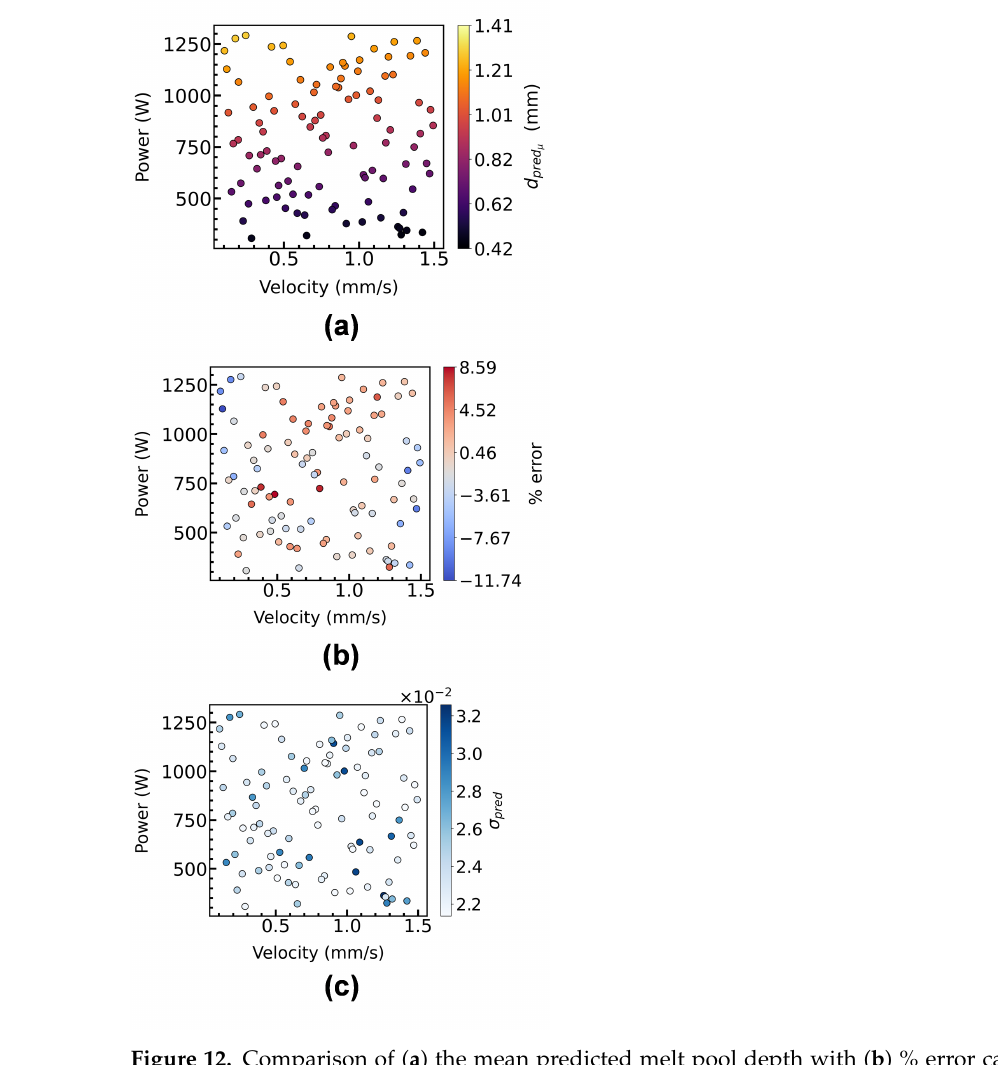
pred associated with each prediction, for MFGP